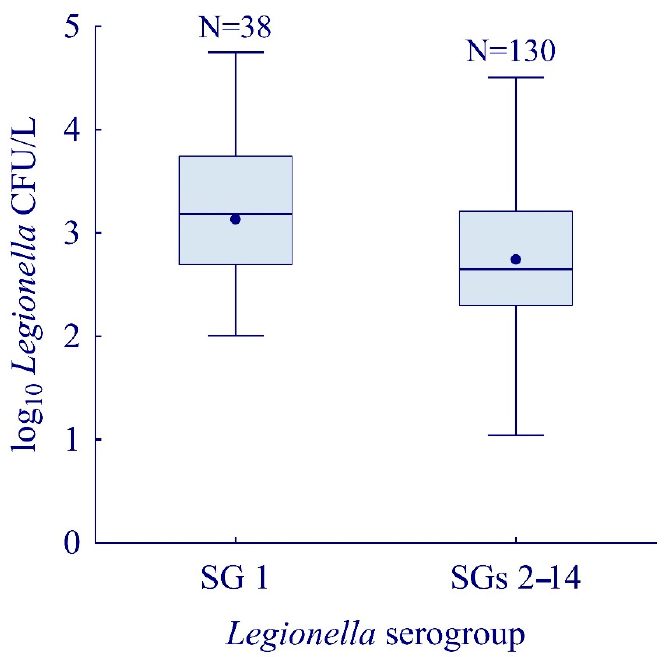
Figure 2. Legionella load in relation to strains. Boxplots show median (line), mean (point), quartiles (boxes), and non-outlier L. pneumophila range (whiskers). (boxes), and non-outlier L. pneumophila range